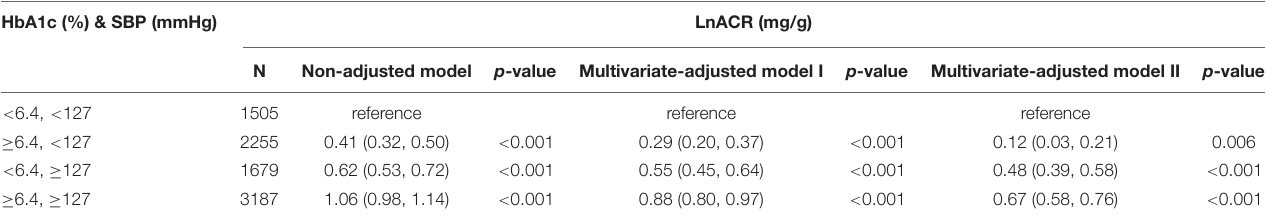
TABLE 4 | Analysis of the combined threshold effect of both HbA1and SBP on ACR. HbA1c (%) & SBP